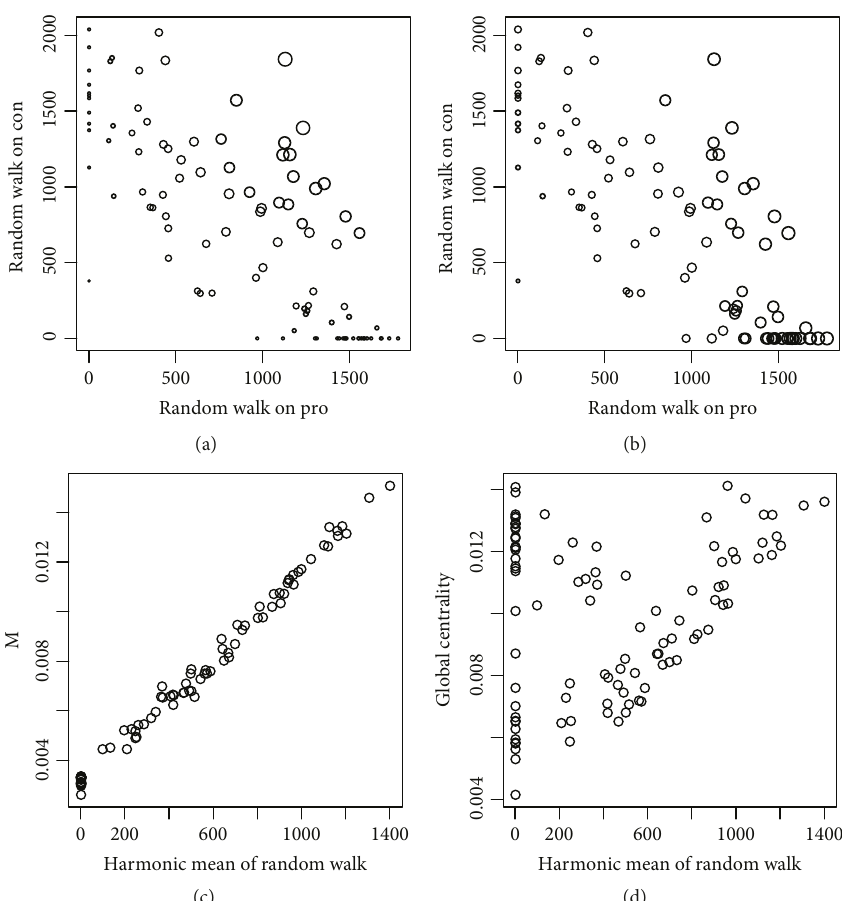
Figure 8: Comparison of mediation centrality and global centrality against random walk residence times in Simulation 2. Each individual is represented by a dot. (a) Random walk residence times for pro and con reasons. Dot size represents mediation centrality value. (b) Random walk residence times for pro and con reasons. Dot size represents global centrality. (c) Mediation centrality against random walk residence times. (d) Global centrality against random walk residence